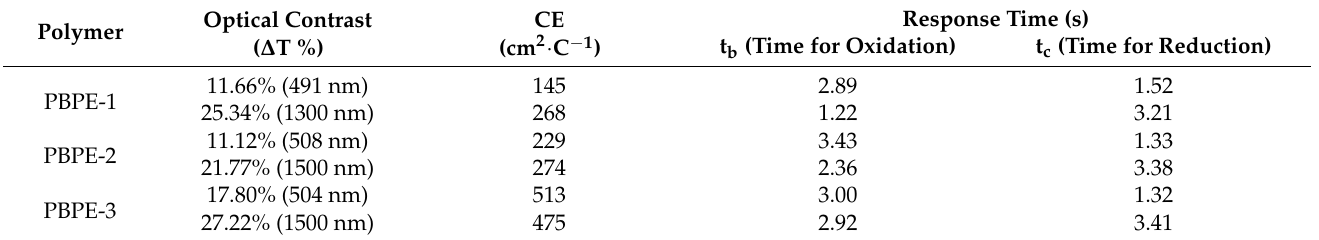
Table 2. Optical contrasts ( ∆ T%), coloration efficiencies (CE) and response times (t 95% ) of PBPE-1, PBPE-2 and PBPE-3.